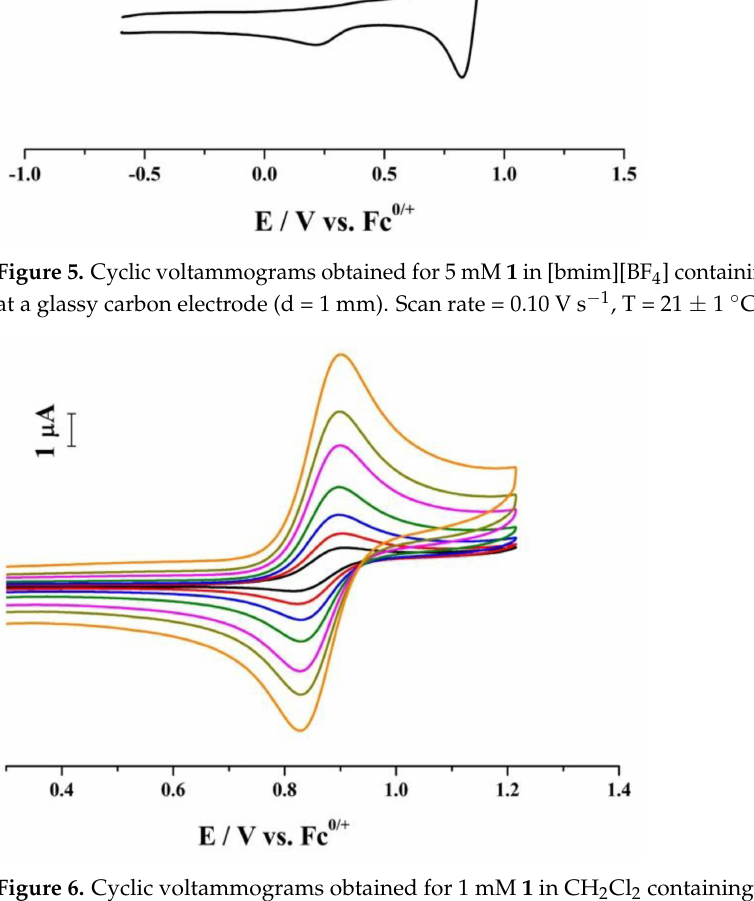
Figure 6. Cyclic voltammograms obtained for 1 mM 1 in CH 2 Cl 2 containing 1 M [bmpyr][NTf 2 ] as supporting electrolyte at a glassy carbon electrode (d = 1 mm) over the potential region where the oxidation occurs at scan rates of 0.02, 0.05, 0.10, 0.20, 0.40, 0.60, and 1.0 V s − 1 . T = 21 ± 1 ◦